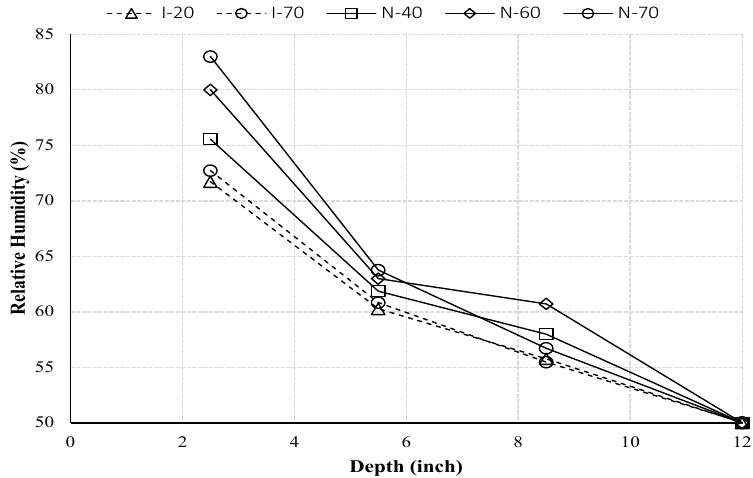
Figure 5. Relative humidity profiles for all samples varies with time increasing at same depth ( x = 5.5 inch).